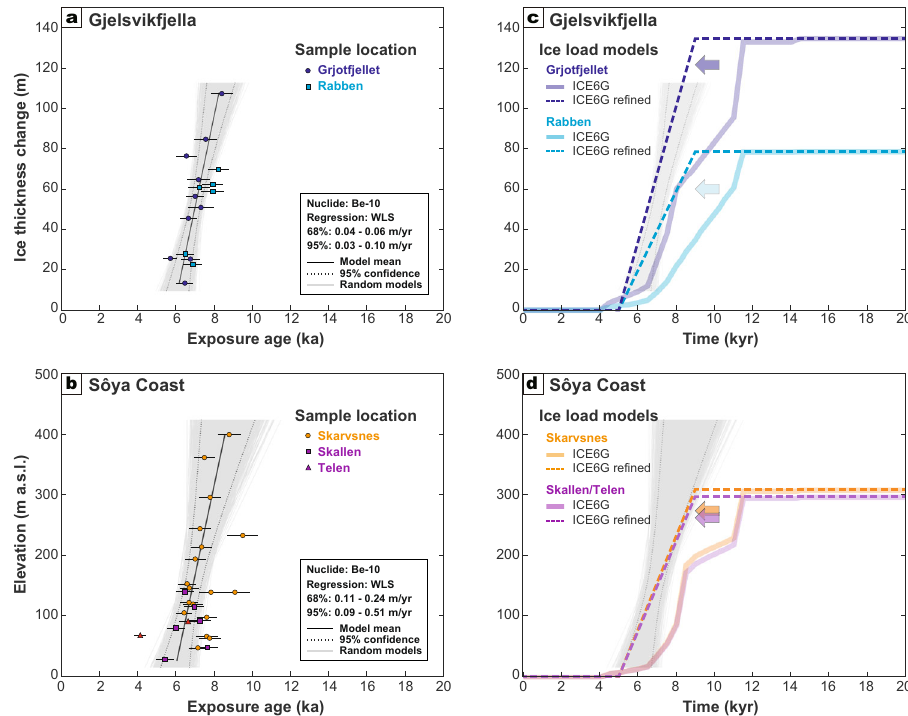
Fig. 6 Comparison of ice-sheet thinning in Droning Maud Land using surface exposure ages and ice load models since the LGM. a , b Results of linear regression analysis to determine a best- fi t pro fi le of ice surface lowering in Gjelsvikfjella (this study), western-central DML and the Sôya Coast, Lützow- Holm Bay, eastern DML 31 (Fig. 1b) by using the iceTEA toolkit 32 . The exposure ages used for the analysis in Gjelsvikfjella are circled in Fig. 4. All exposure ages from the Sôya Coast 31 except for bedrock and recent moraine samples are used for the analysis (see Supplementary Data 3). Exposure ages are shown with 1 σ external errors and are plotted against relative heights above the contemporary ice sheet surface for Gjelsvikfjella and elevation for the Sôya Coast. Gray lines represent all models that fi t the data, the solid black line is the best- fi t to the data, and dotted black lines represent the 95% con fi dence interval. Rates of lowering were generated from 5000 iterations through randomly sampled points using 2 σ internal uncertainties. c , d Ice load models for each area based on ICE6G 42 and its re fi ned version based on the fi eld-based ice thinning histories for Gjelsvikfjella ( c ) and the Sôya Coast ( d